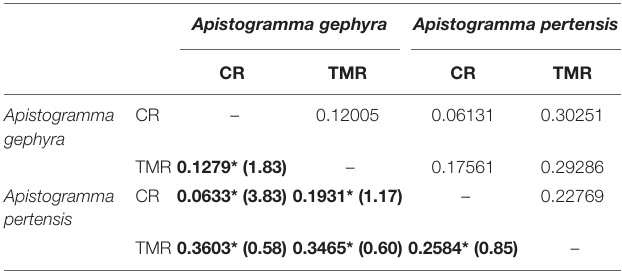
TABLE 3 | Analysis of molecular variance (AMOVA) of Apistogramma gephyra and Apistogramma pertensis based on the 11 microsatellite